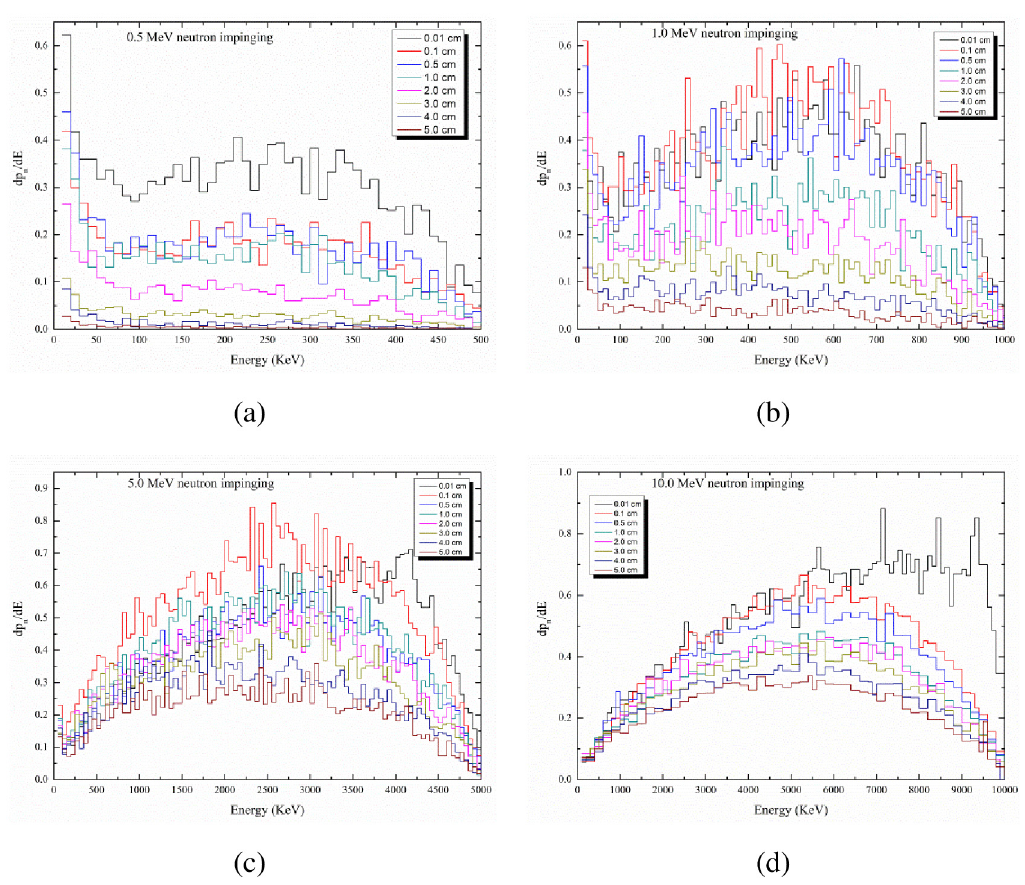
Fig 8. Distribution of protons as a function of the proton energy with the thickness of the PE layer as a parameter (in cm). (a) For incident neutron energy of 0.5 MeV; (b) for incident neutron energy of 1 MeV; (c) for incident neutron energy of 5 MeV; (d) for incident neutron energy of 10